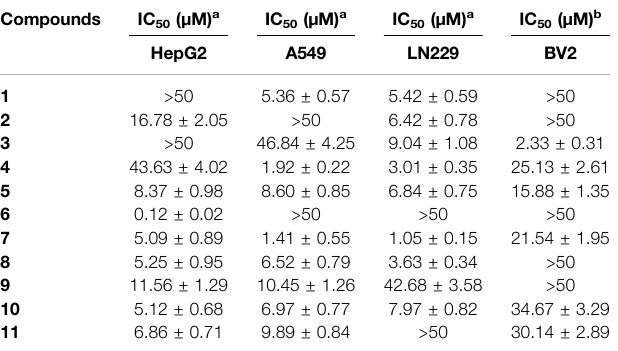
TABLE4| Antiproliferativebioassaysandinhibitoryactivity againstNOproduction in LPS-stimulated BV2 of compounds 1 – 11 .